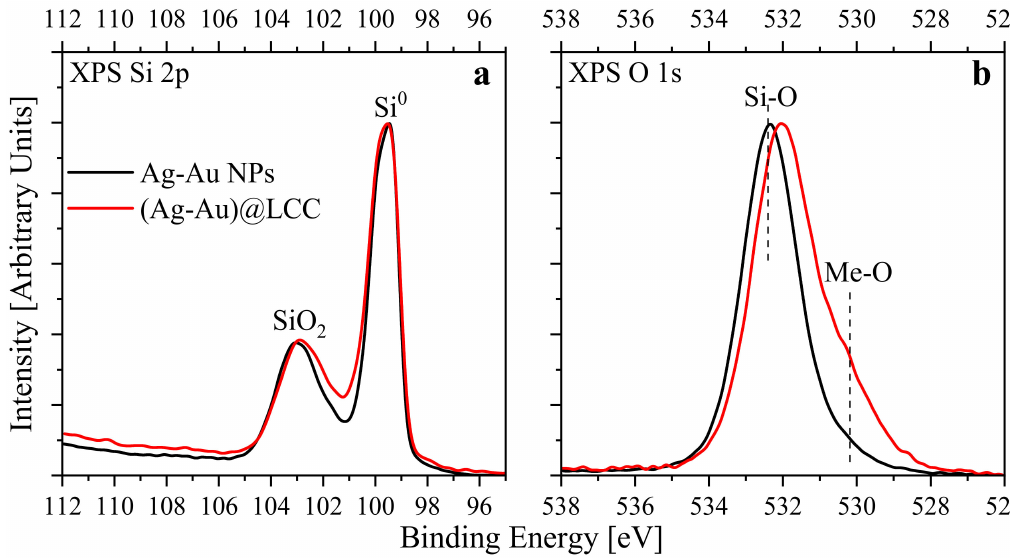
Figure 4. XPS spectra of Ag-Au and (Ag-Au)@LCC: ( a ) Si2p and ( b ) O 1s.